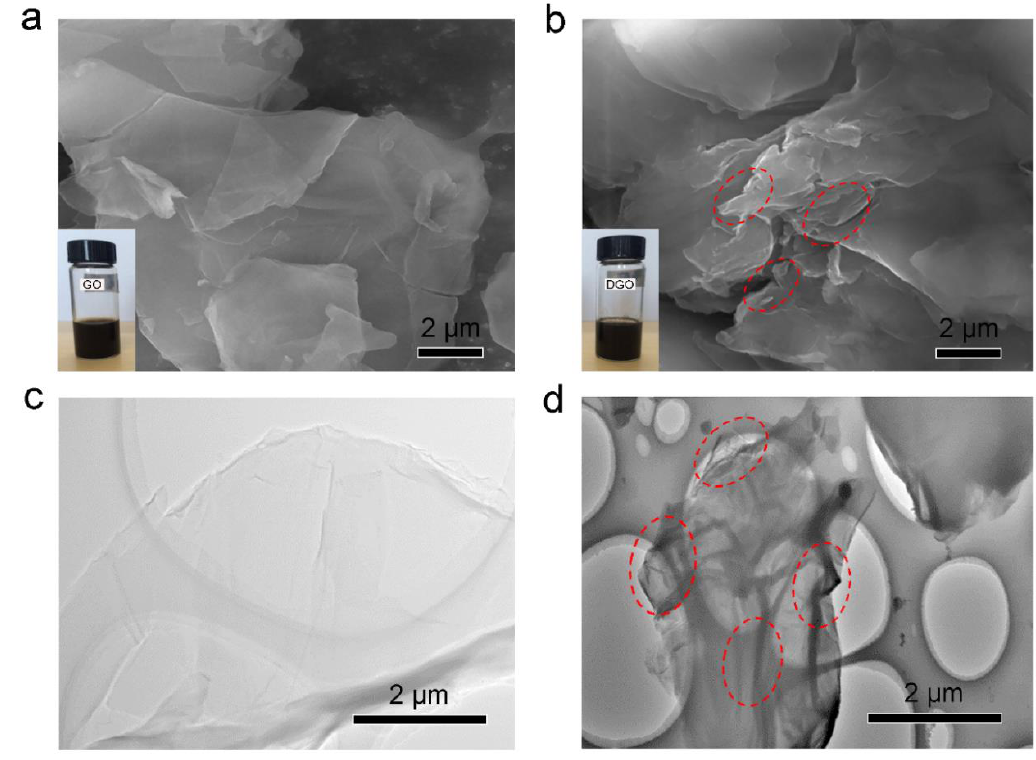
Figure 3. SEM images of GO ( a ) and DGO ( b ) (the insets were optical photographs of GO and DGO after being dispersed in water for 100 h), and TEM images of GO ( c ) and DGO ( d